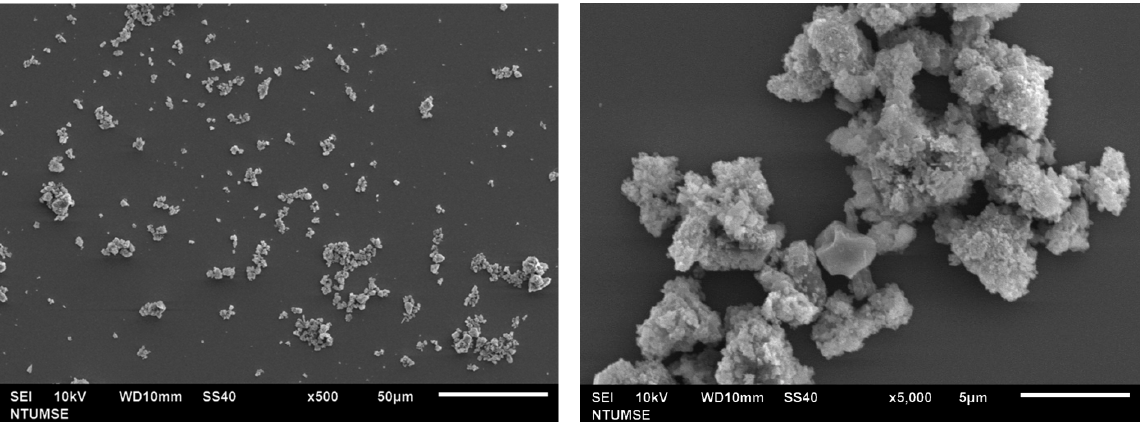
Figure 3. SEM micrograph of N-TiO 2 .